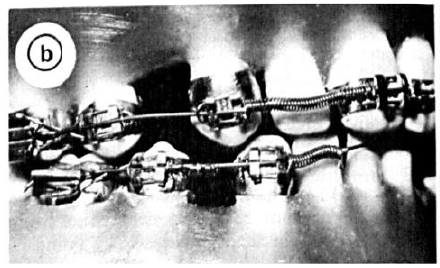
Figure (6): Canine retraction using coil spring compressed between a soldered stop on the archwire and the canine bracket in the lower arch and coil springs compressed between an incisor bracket and the canine tooth in the upper arch (d) Coil spring compressed by a tie-back